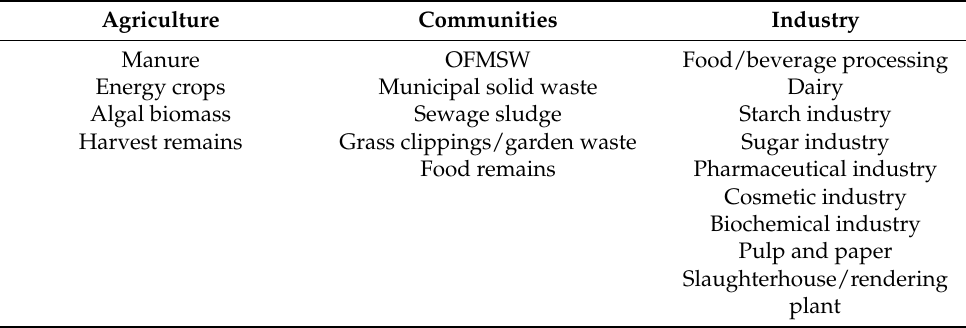
Table 1. Survey of the Various Feedstocks from Different Sources.